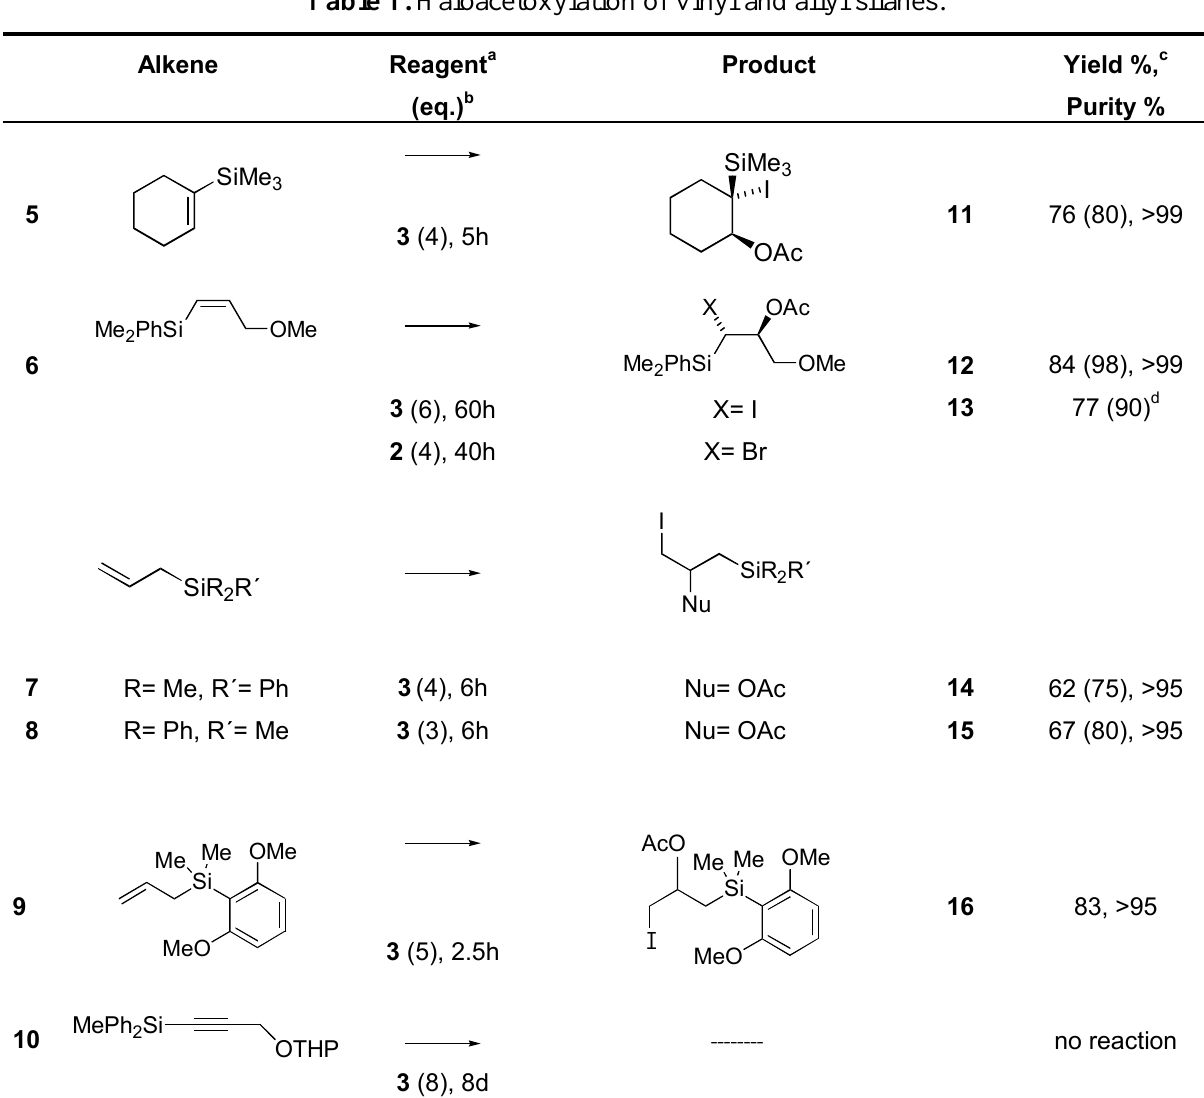
Table 1. Haloacetoxylation of vinyl and allyl